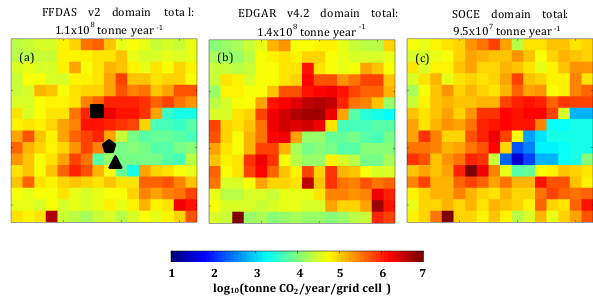
Figure 3. Comparison of spatial distribution of annual CO 2 emis- sions inventories for the black-box area (shown in Fig. 2a) at 0.1 ◦ × 0.1 ◦ resolution. Panel (a) shows the FFDAS v2 inventory estimate, panel (b) shows the EDGAR v4.2 inventory estimate, and panel (c) shows the SOCE inventory estimate. Domain totals are shown on top of each panel and locations of in situ measurements of CO 2 for three stations in the Southern Ontario Greenhouse Gas Network are shown in panel (a) (Downsview is a square, Hanlan’s Point is a triangle, TAO is a pentagon). The other two stations, Eg- bert and Turkey Point, are located outside this area.